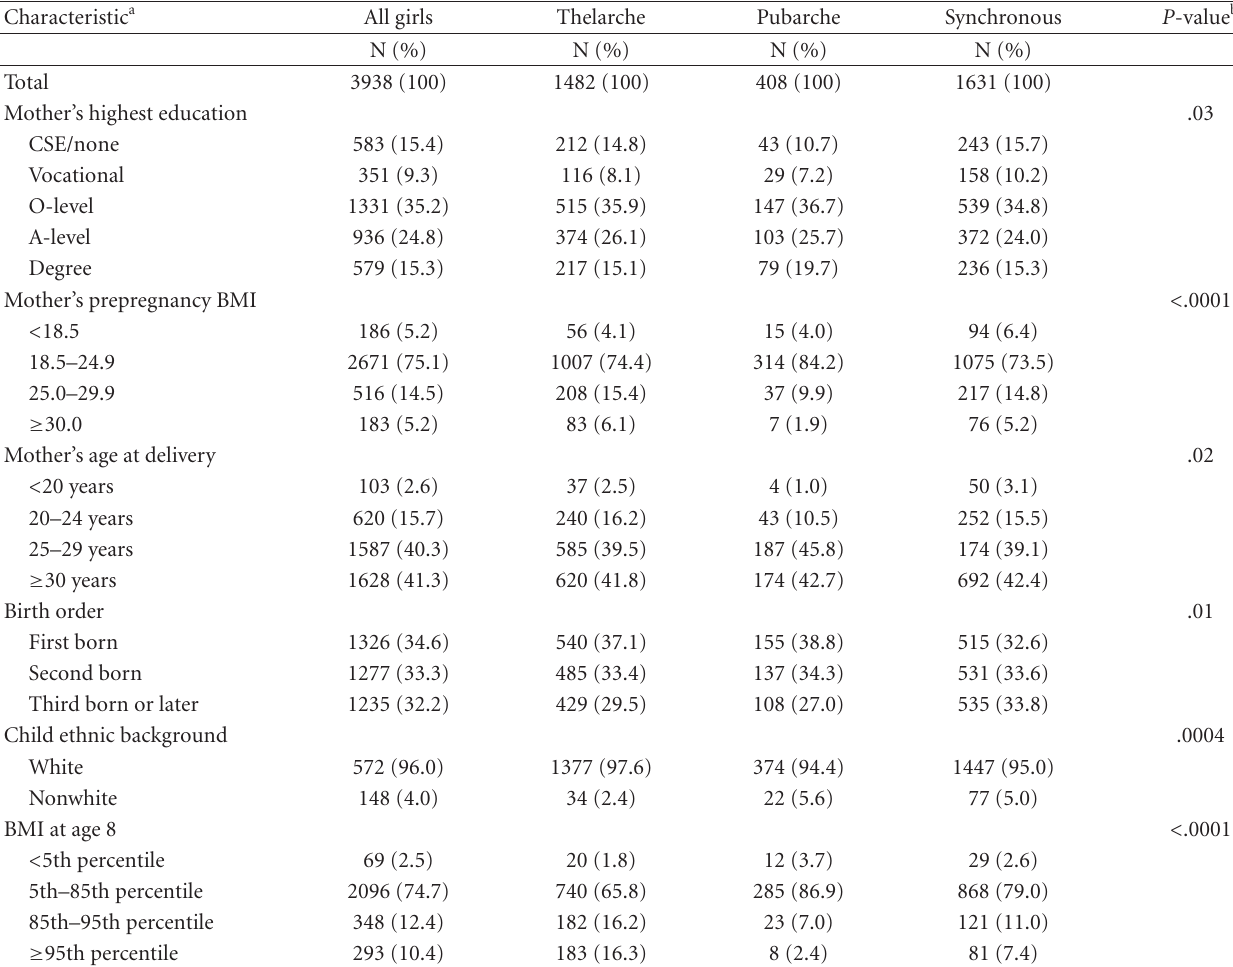
Table 2: Characteristics of study participants, overall and by initiation